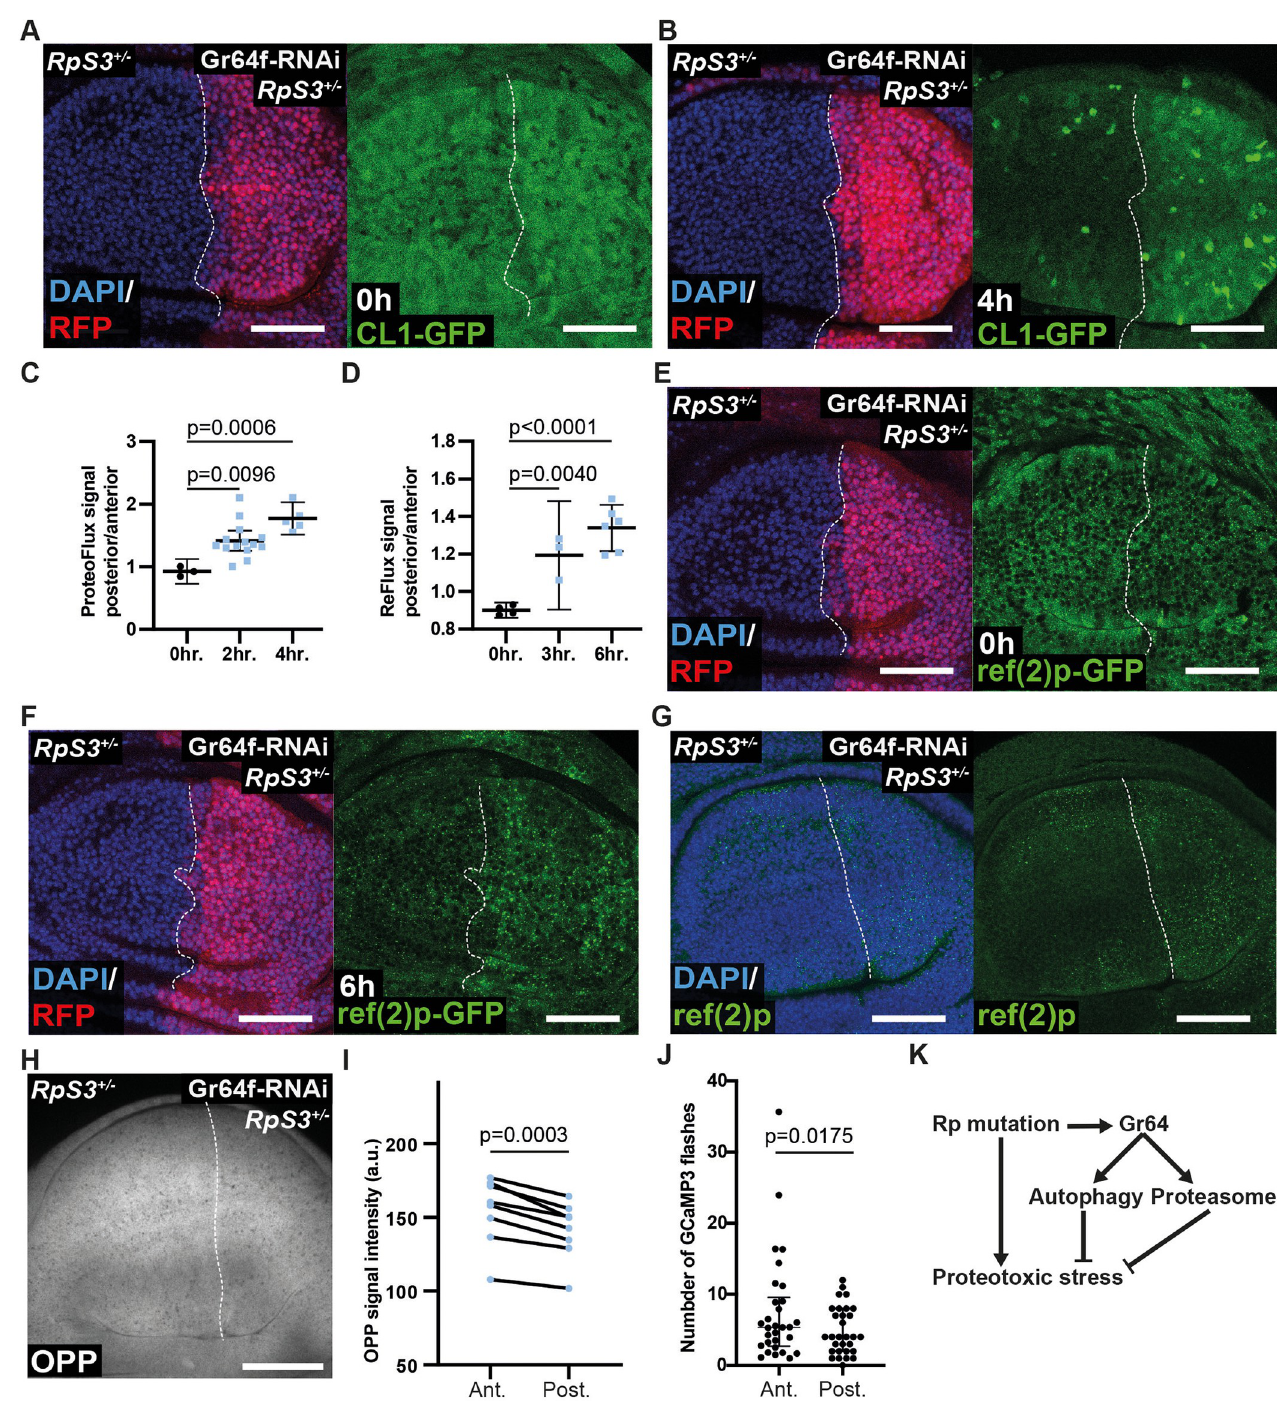
Fig 4. Loss of Gr64 exacerbates proteostasis defects in RpS3 +/- . ( A – C ) RpS3 +/- wing discs expressing Gr64f-RNAi driven by enGal4 in the posterior compartment, marked with RFP (red) and expressing the CL1-GFP/ProteoFlux construct (green), 0 hours ( A ) or 4 hours ( B ) after heat shock along with quantification in ( C ) (n 0hr = 3, n 2hr = 14, n 4hr = 5, 2-sided paired t test, the horizontal line indicates the mean and the whiskers reflect the 95% confidence interval). ( D – F ) RpS3 +/- wing discs expressing Gr64f-RNAi driven by enGal4 in the posterior compartment, marked with RFP (red) and expressing the ref(2) P-GFP/ReFlux construct (green), 0 hours ( E ) or 6 hours ( F ) after heat shock along with quantification in ( D ) (n 0hr = 4, n 3hr = 3, n 6hr = 6, 2-sided paired t test, the horizontal line indicates the mean, and the whiskers reflect the 95% confidence interval). ( G ) RpS3 +/- wing discs expressing Gr64f-RNAi driven by enGal4 in the posterior compartment stained for ref(2)P (green). ( H , I ) RpS3 +/- wing discs expressing Gr64f-RNAi driven by enGal4 in the posterior compartment and assessed for translation through an OPP translation reporter assay (grey) ( H ) along with quantification in ( I ) ( n = 8, 2-sided paired t test). ( J ) Quantification of